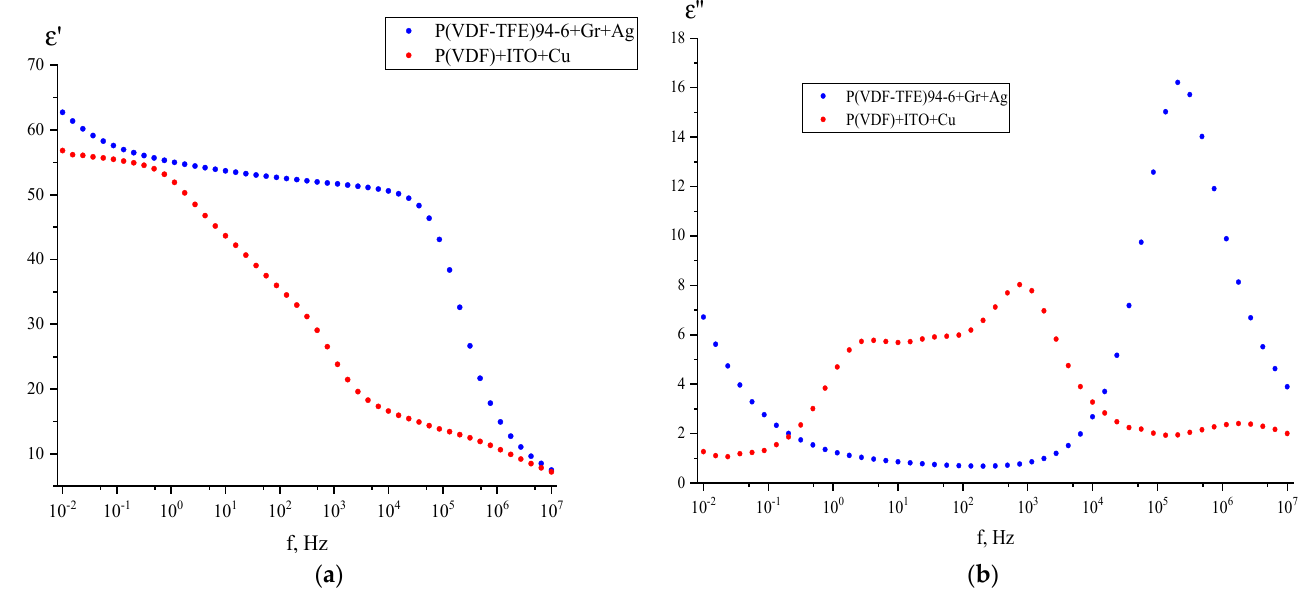
Figure 7. Frequency dependences of the real ( a ) and imaginary ( b ) components of the complex permittivity of PVDF with ITO.